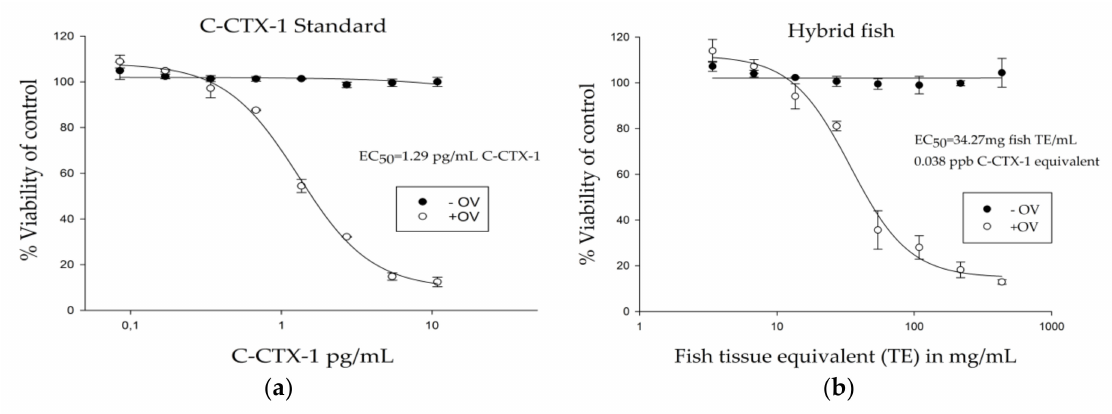
Figure 4. In vitro cell assay of ( a ) C-CTX-1 reference standard, the 8-pt concentration-response curve was applied starting at 10.9 pg / mL (EC 50 = 1.29pg / mL), and ( b ) hybrid fish tissue extract, the 8-pt concentration-response curve was applied starting at 434.8 mg / mL (EC 50 = 34.27 mg / mL). In addition to the samples, + OV wells received 20 µ L ouabain and veratridine solution, − OV wells received 20 µ L bu ff er solution